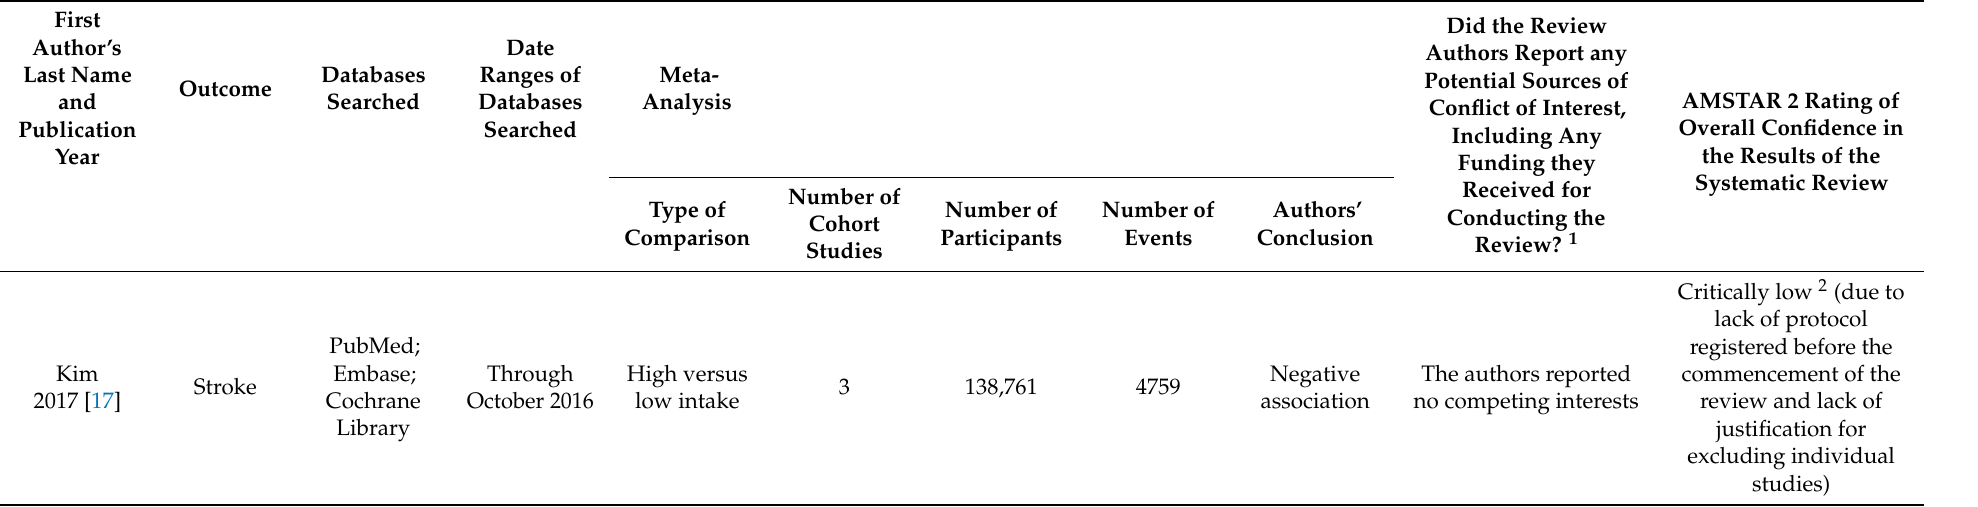
Table 2. Descriptive characteristics of systematic reviews on associations between unprocessed poultry and